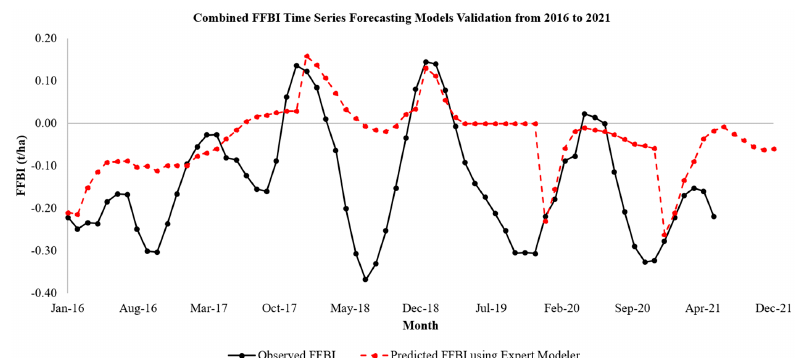
Figure A3. FFBI time series forecasting validation models (total of 6 models combined). Modelled period: moving 30 years starting from 1986 (N = 360) with 12 months forecasted period. Note: Predicted FFBI (Red dash line) from January 2016 to December 2016 are values predicted from 1986–2015 model and so on with a moving 30 years validation.